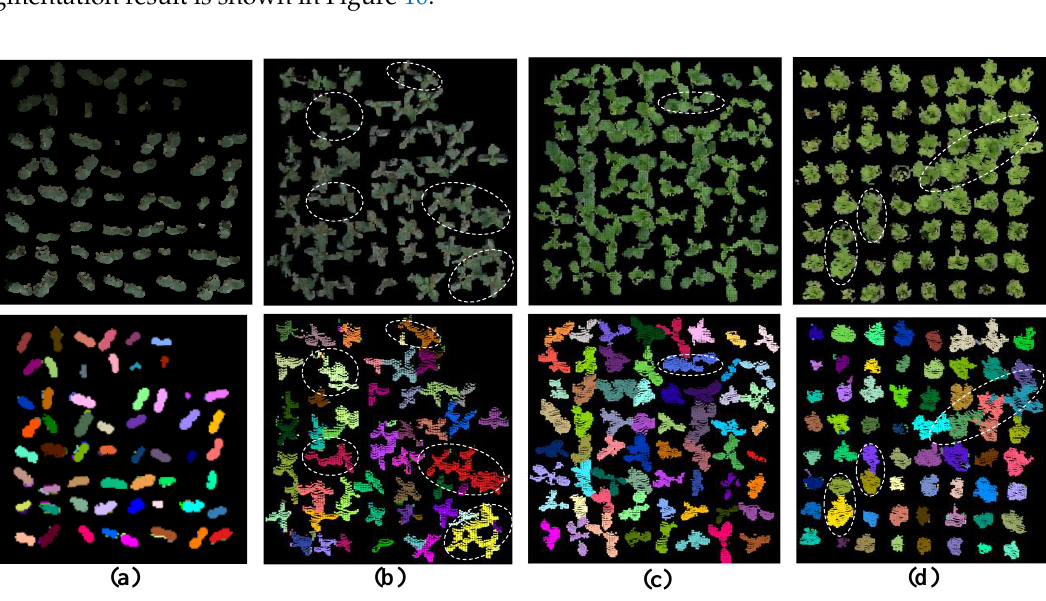
Figure 9. Typical example of single seedling partition processing results from four varieties of vegetable seedlings planted in di ff erent seedling trays, grown in two types of environment: ( a ) cucumber ( b ) tomato, ( c ) pak choi cabbage, ( d ) lettuce; ( a , b ) soil culture, ( c , d ) hydroponic; ( a – c ) grown in plant factory, ( d ) grown in greenhouse. Parameters: R voxel = 0.0038, R seed = 0.0018, and β thresh = 10 ◦ .